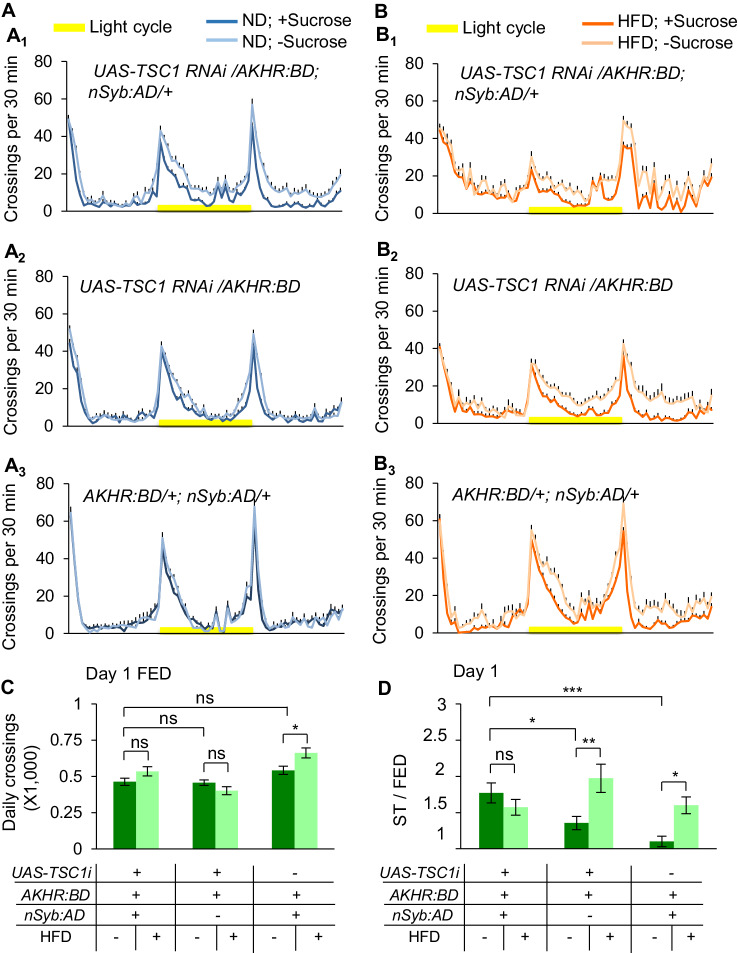
Knocking down TSC1 in AKHR+ neurons promotes starvation-induced hyperactivity.(A–B) Midline crossing activity of indicated genotypes and diet treatments assayed in the presence or absence of 5% sucrose (n = 36–46). (C) Average daily midline crossing activity of fed flies assayed in A-B. (D) Starvation-induced hyperactivity of flies assayed in A-B. ns, p>0.05; *p<0.05; **p<0.01; ****p<0.0001. Student’s t-test, one-way and two-way ANOVA followed by post hoc test with Bonferroni correction were used for multiple comparisons when applicable.